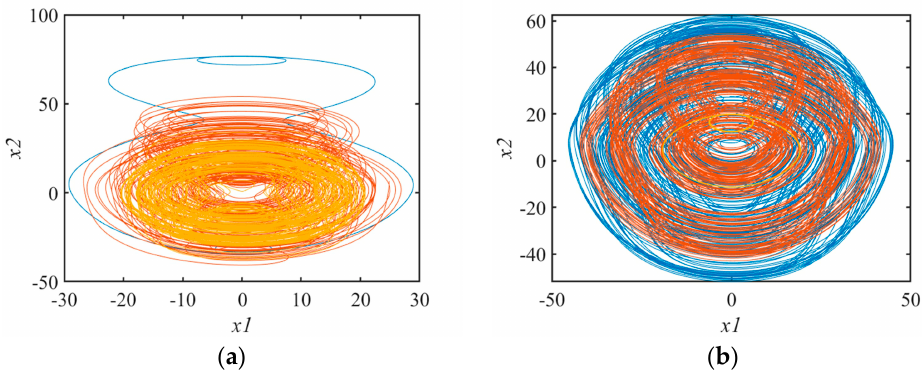
Figure 13. Coexistence of attractors with different initial conditions. ( a ) a = 2, b = 11, c = 20, d = 10, e = 1; ( b ) a = 0.3, b = 11, c = 20, d = 10, e = 7.